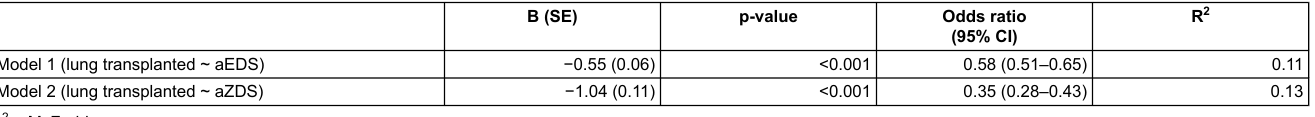
Table 4: Results of two independent binary logistic regression models including the adapted Eurotransplant donor score (aEDS) and adapted Zurich donor score (aZDS), each as a single predictor for being transplanted in